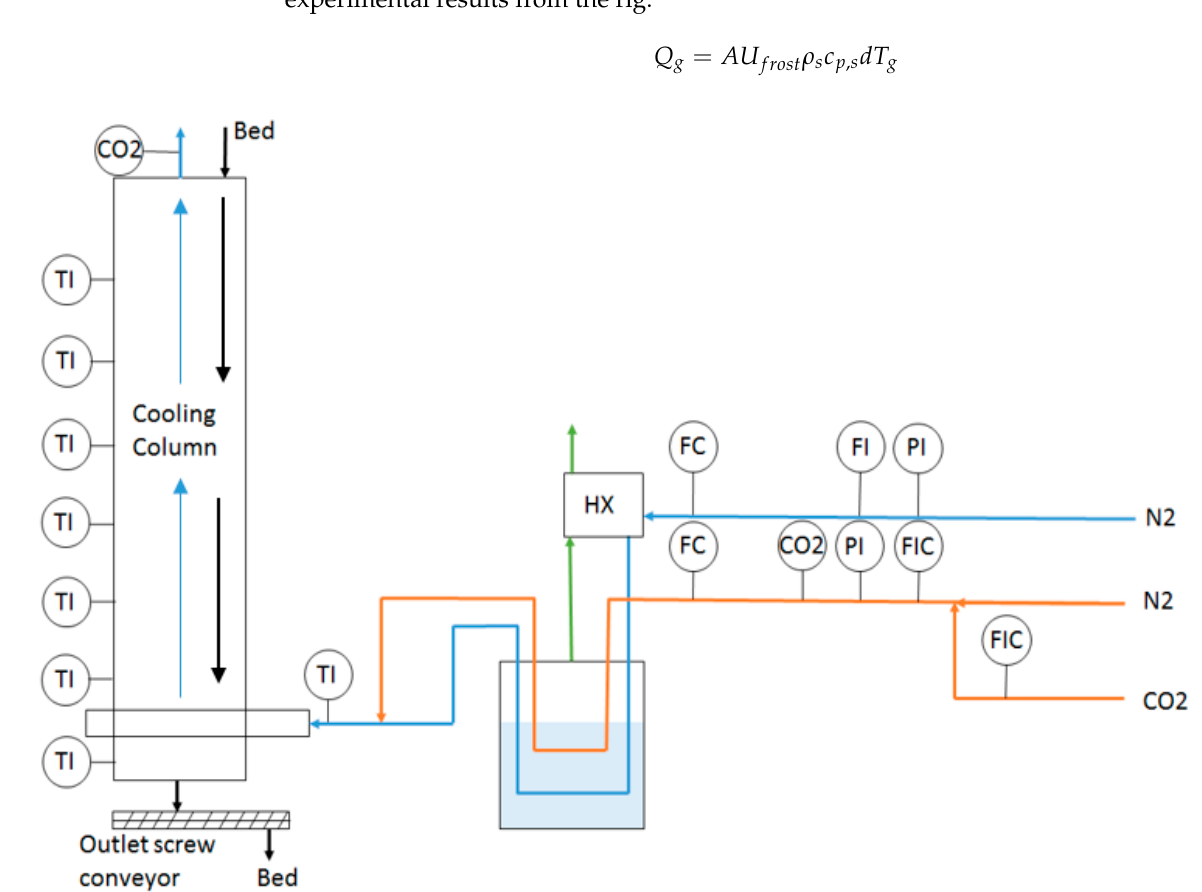
Figure 2. Sketch diagram of the experimental rig [11]. TI, temperature indicator (type K thermocouple), CO 2 , GSS ExplorIR ® ‐ W CO 2 sensor, HX, heat exchanger, FC, flow controller (on/off valve), FIC, flow indicator and controller (rotameter and flow control valve), PI, pressure indicator (pressure gauge).